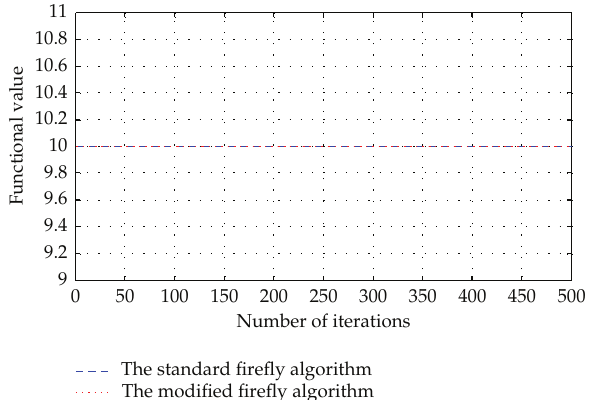
Figure 3: Simulation result of the third test problem.